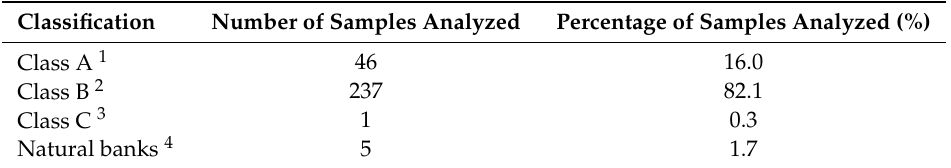
Figure 1. Shellfish sampling area (Campania region: Southeast Italy). The sampling areas are indicated by yellow dots. Table 2. Classification of shellfish samples (as defined from Reg CE 854 /